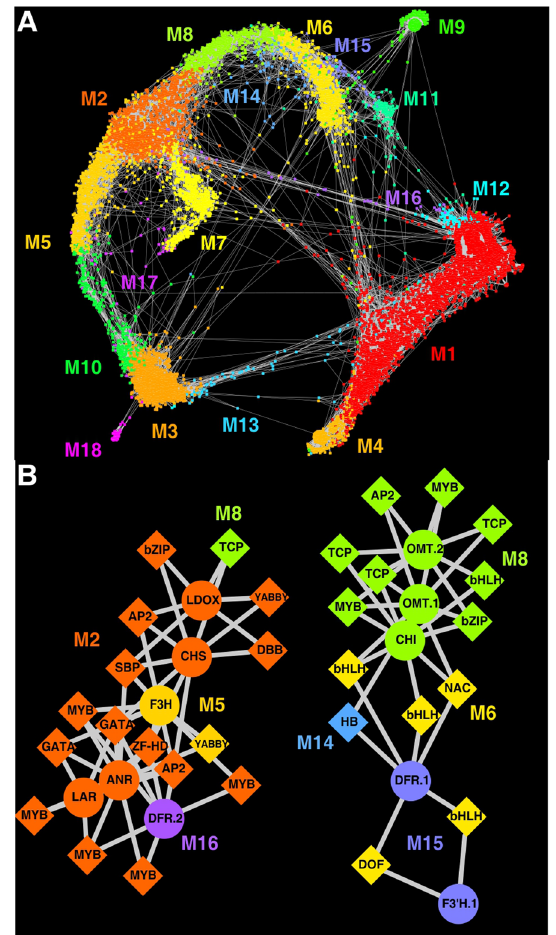
Figure 7. A . amnicola transcriptome co-expression networks. ( A ) Visualization of the 18 co-expression modules among the differentially expressed genes detected by WGCNA. Each node represents an individual differentially expressed gene (10,440) and each edge (577,405) represents a co-expression measure between two connected nodes, with shorter edges indicating higher co-expression. Nodes are colored by co-expression module membership and labeled M1 through M18 (Supplementary Fig. S2). ( B ) Transcription factors connected to at least two flavonoid biosynthesis unigenes when analyzing the top ten transcription factors with the highest co-expression values for each flavonoid unigene. Flavonoid biosynthesis unigenes (11) are shown as circles, and transcription factors (30) are shown as diamonds and labeled as their transcription factor class. Nodes are colored by their co-expression module membership. Edges connecting each transcription factor to a flavonoid unigene are weighted by topological overlap measures with shorter edges indicating stronger co- expression. Flavonoid biosynthesis unigene IDs are shown in Supplementary Table S5 and transcription factor unigene IDs are shown in Supplementary Table